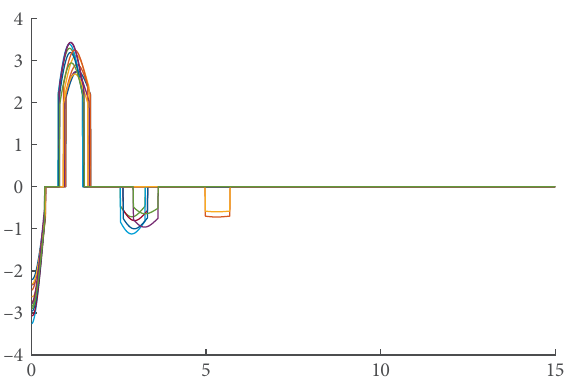
Figure 5: The error convergence of the position and the area constraint of a six-agent.